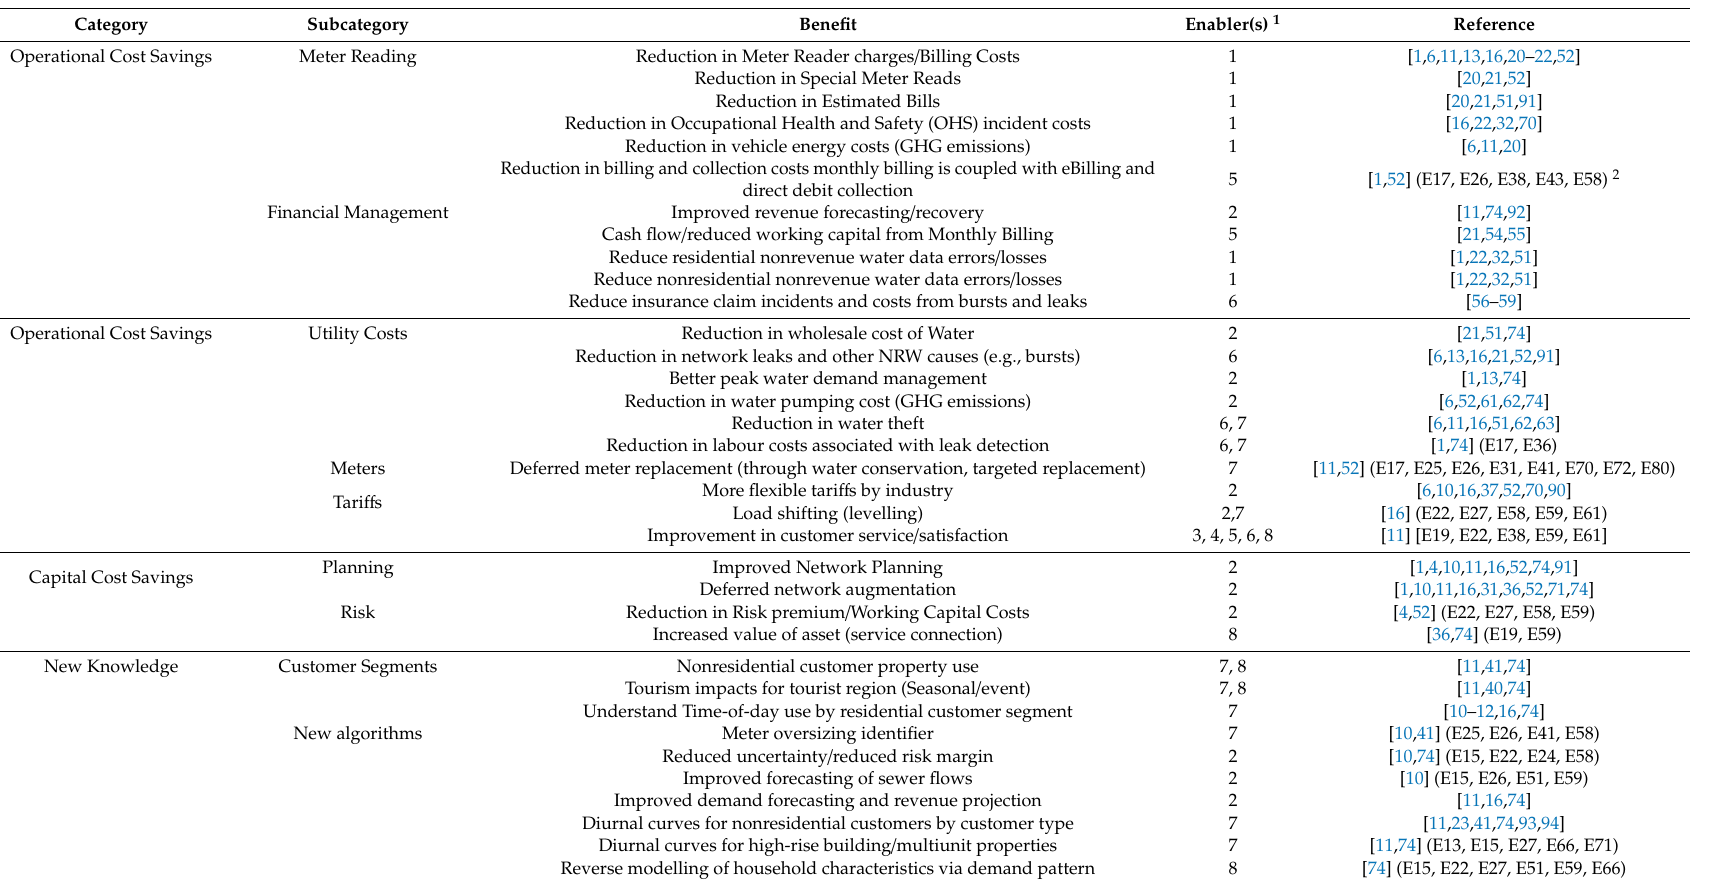
Table 2. The benefits available to water utilities from changing to digital water